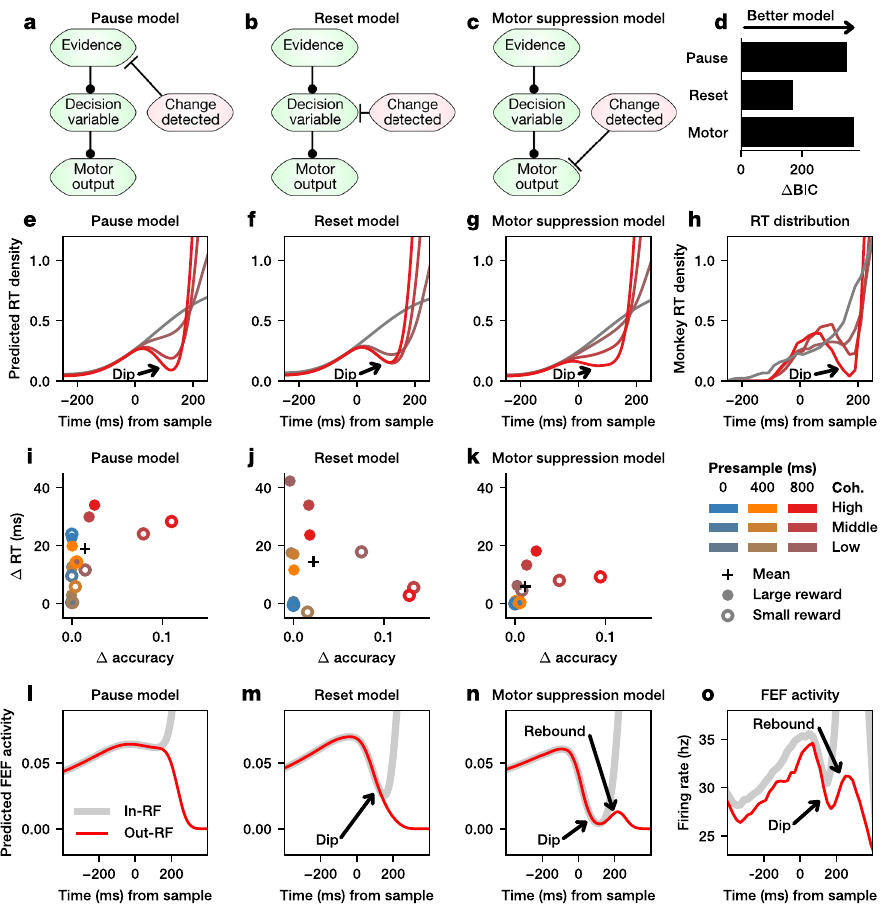
Fig. 6 Comparison of computational models of the dip. Schematic of the ( a ) pause model, ( b ) reset model, and ( c ) motor suppression model across stages of the decision-making process. d The fi t of each GDDM to the RT distribution, as quanti fi ed by BIC, is shown for each of the three models. The simulated RT distribution for 800 ms presample at the time of evidence onset is shown for the ( e ) pause, ( f ) reset, and ( g ) motor suppression models. h The RT distribution for Monkey 1 in 800ms presample trials at the time of evidence onset. For each coherence, presample, and reward condition, the difference in mean RT and accuracy, with and without the dip mechanism, are plotted for the ( i ) pause, ( j ) reset, and ( k ) motor suppression models. Neural predictions of the ( l ) pause model, ( m ) reset model, and ( n ) motor suppression model, based on the mean decision variable or motor-decision variable (see Methods) for inside (in-RF, black) and outside (out-RF, red) the response fi eld on correct high-coherence trials for models fi t to the RT distribution of Monkey 1. o Population activity from FEF neurons in Monkey 1 for correct responses inside (gray) and outside (red) the response fi eld for high-coherence, 800-ms presample